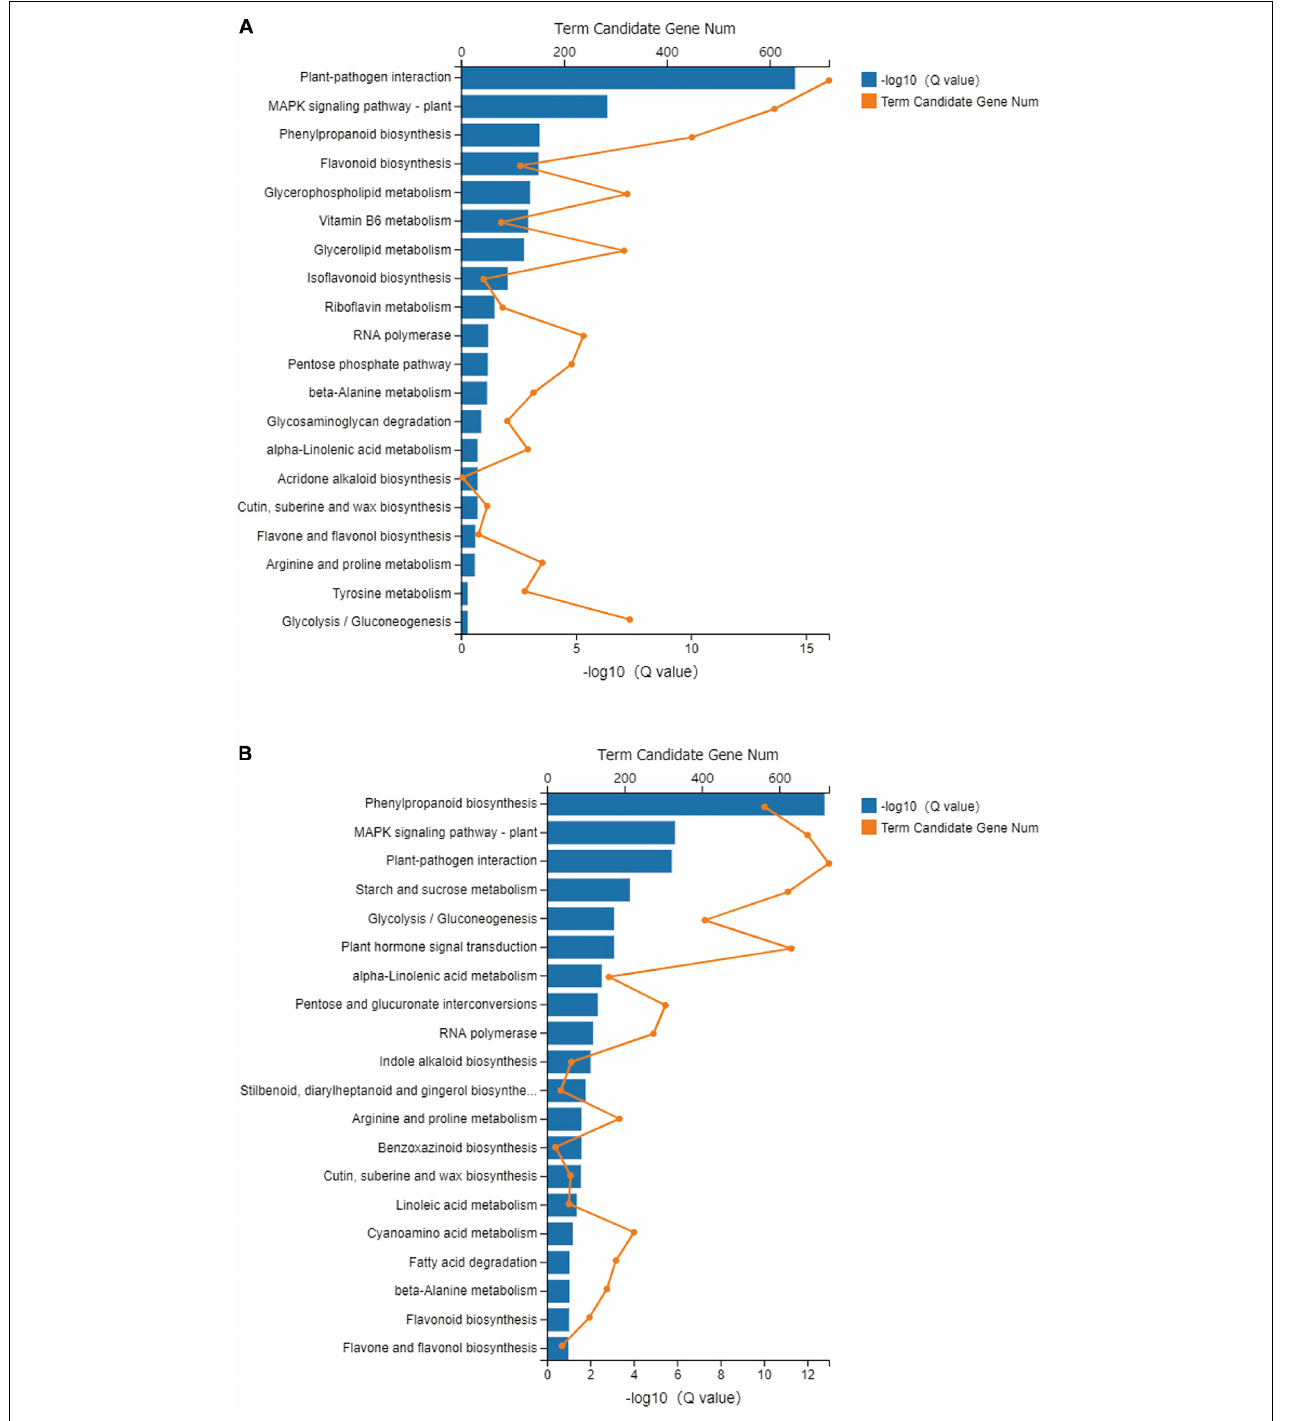
FIGURE 7 | KEGG pathway enrichment analyses in NM-NMP (A) NMP-AMP (B) . NM = uninoculated with S. tortuosa , AM = inoculated with S. tortuosa , NMP = NM inoculated with C. lentis , and AMP = AM inoculated with C. lentis .